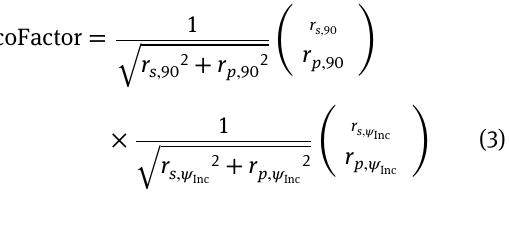
. (b)–(c) Inc , at a series of discrete wavevectors. The polarization ellipses of Inc